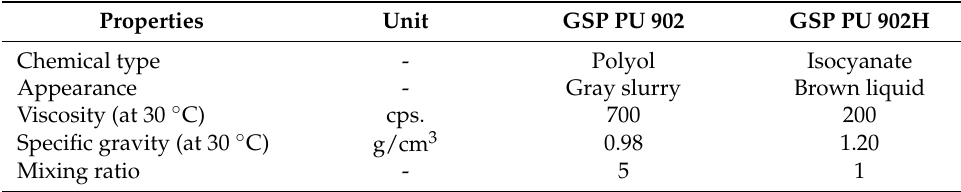
Table 3. Some properties of the polyurethane adhesive used in this